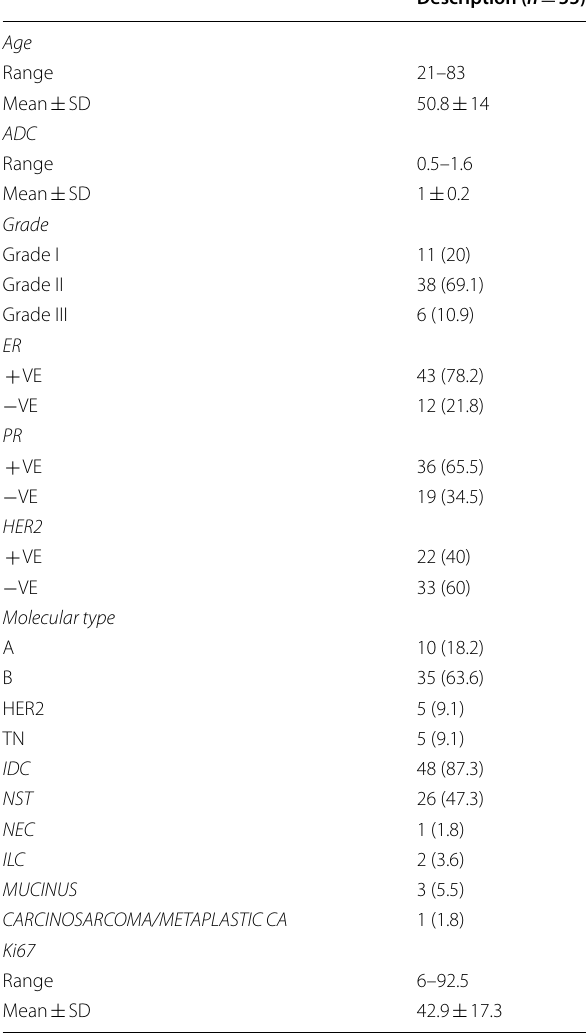
Table 2 Description of study variables